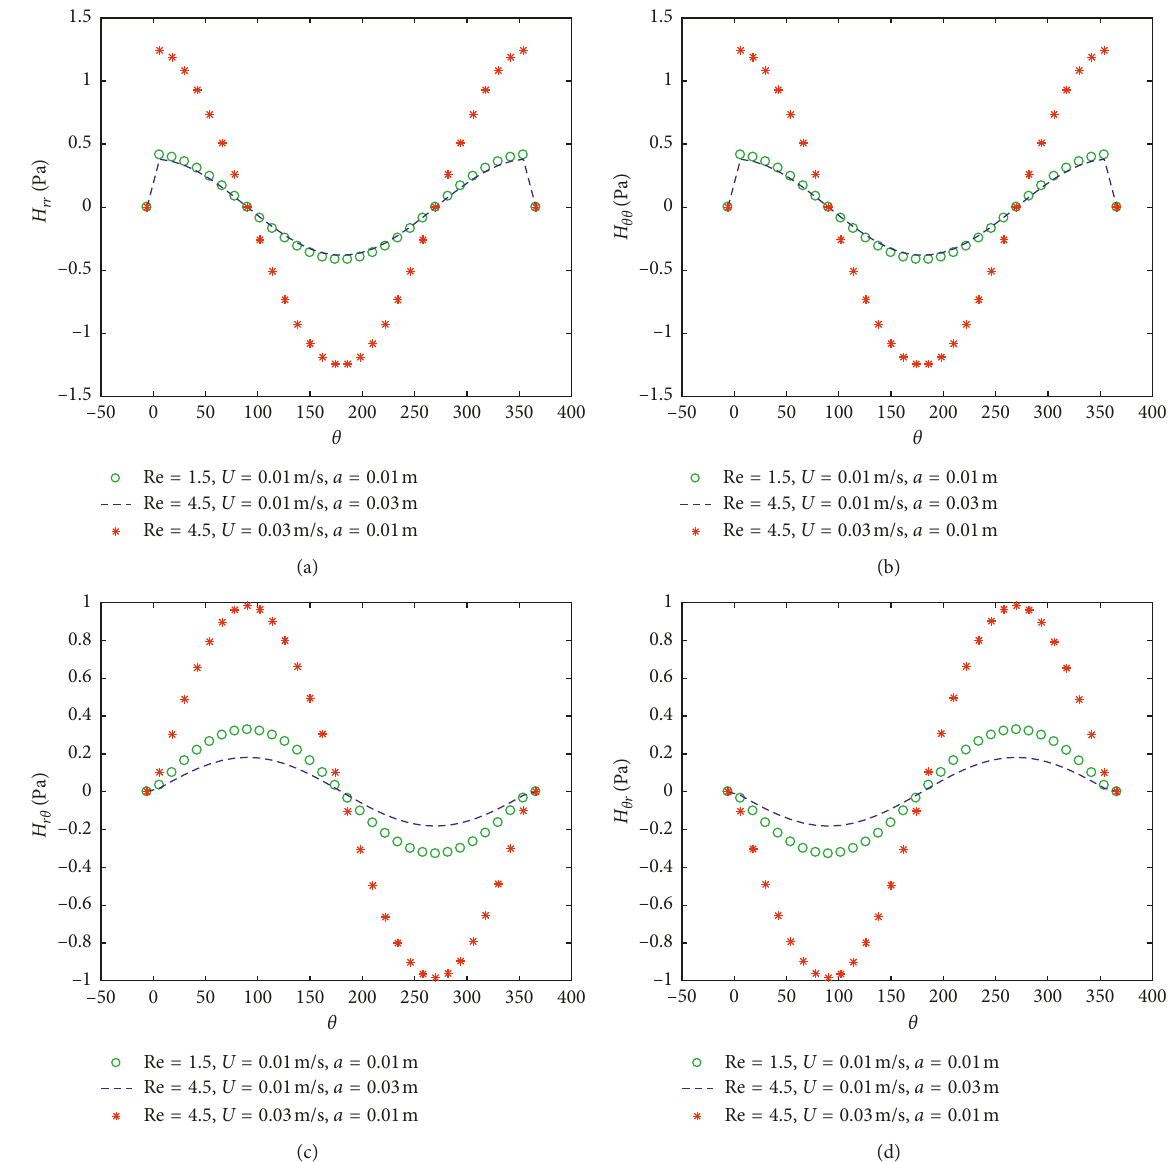
Figure 13: Angular distribution of the normal stress of phason under different Reynolds number at r � 1 . 55 a and t � 350 μ s : (a) radical normal stress, (b) circumferential normal stress, (c) shear stress H r